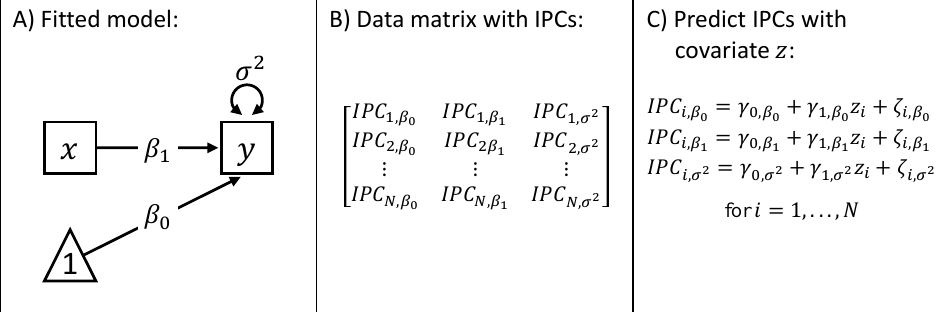
Figure 1. The three steps of IPC regression. Panel A shows the model under investigation. It is not necessary to include any covariates in the model. Panel B visualizes the structure of the new data matrix containing the IPCs. Panel C shows the three IPC regression equations for the respective model parameters. Note that we model the IPCs to each of the three model parameters in a separate regression